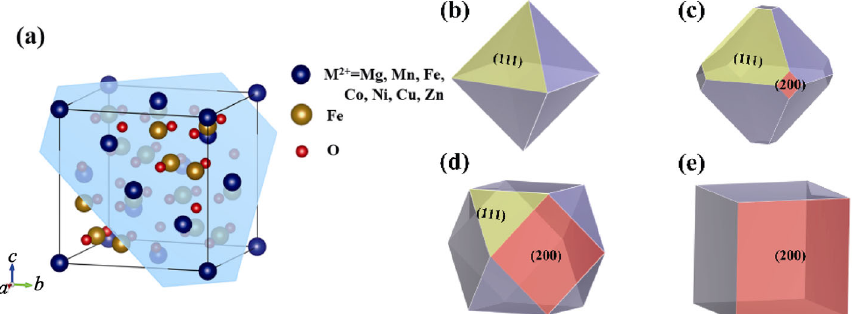
Fig. 3 (a) Crystal structure with marked (111) plane and (b–e) computer-simulated morphologies of spinel ferrites grown with different growth rates on {111} and {200} faces viewed in the [100] direction.